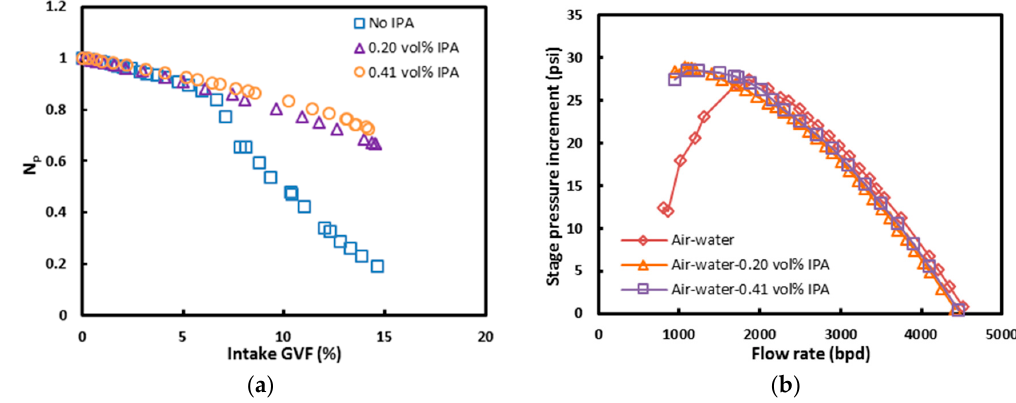
Figure 6. Comparison of ESP two-phase pressure increment with/without surfactant injection [44]. ( a ) Constant liquid flow rate testing; ( b ) constant gas flow rate testing.